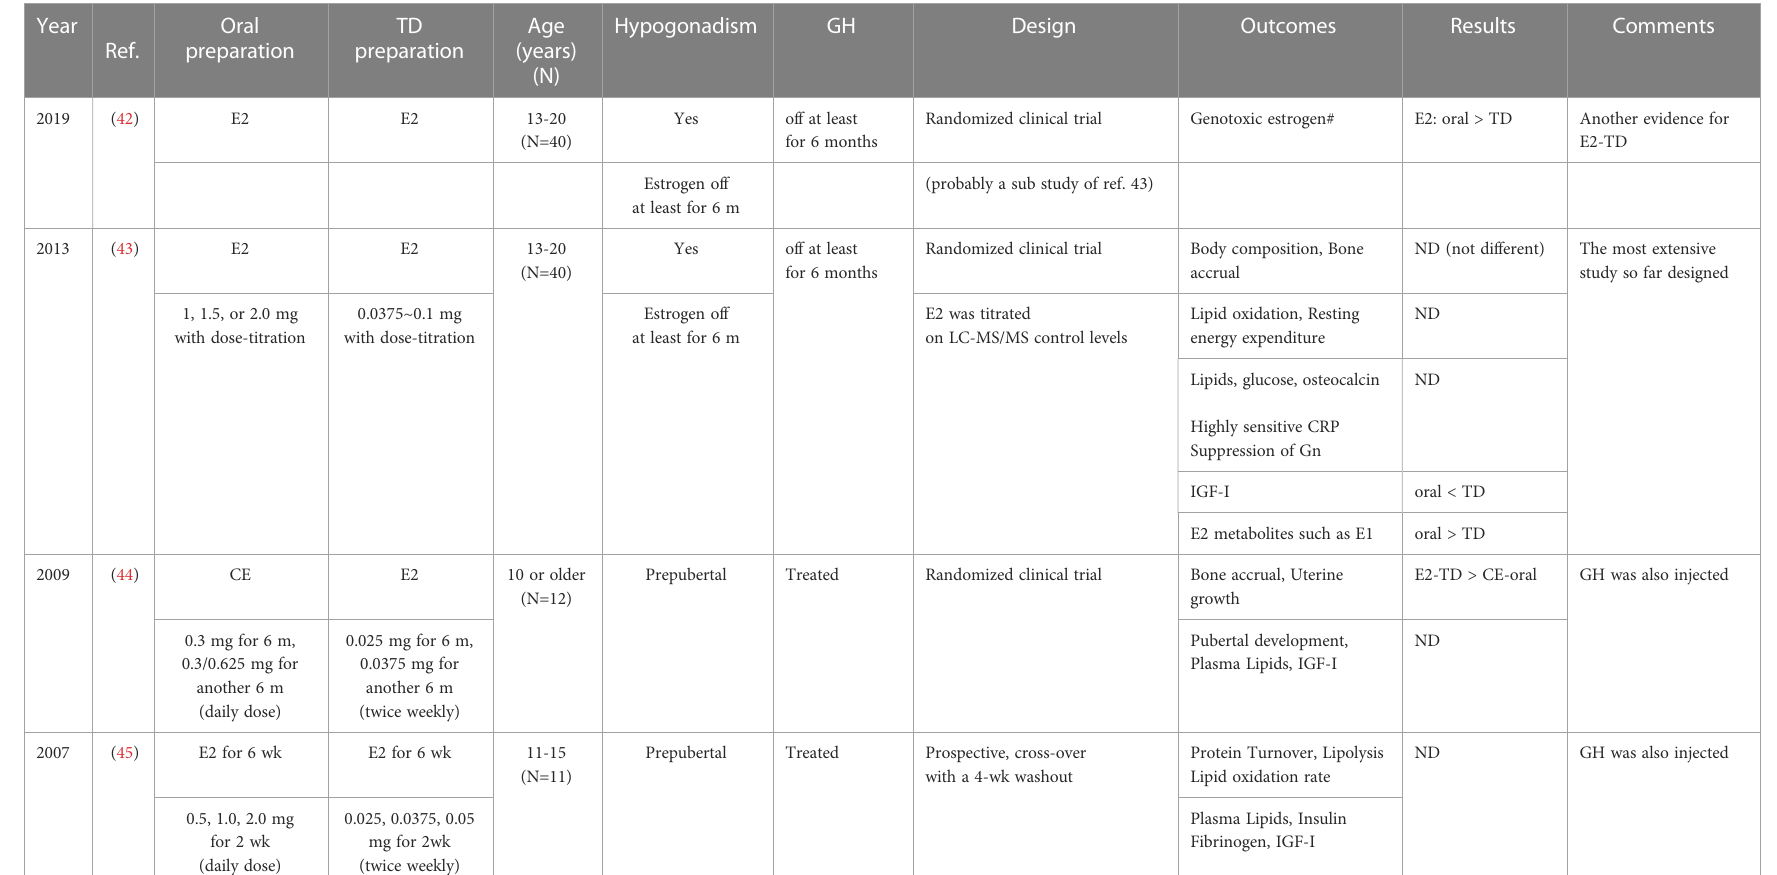
TABLE 3 Direct comparison of oral versus transdermal estrogen initiation in children with